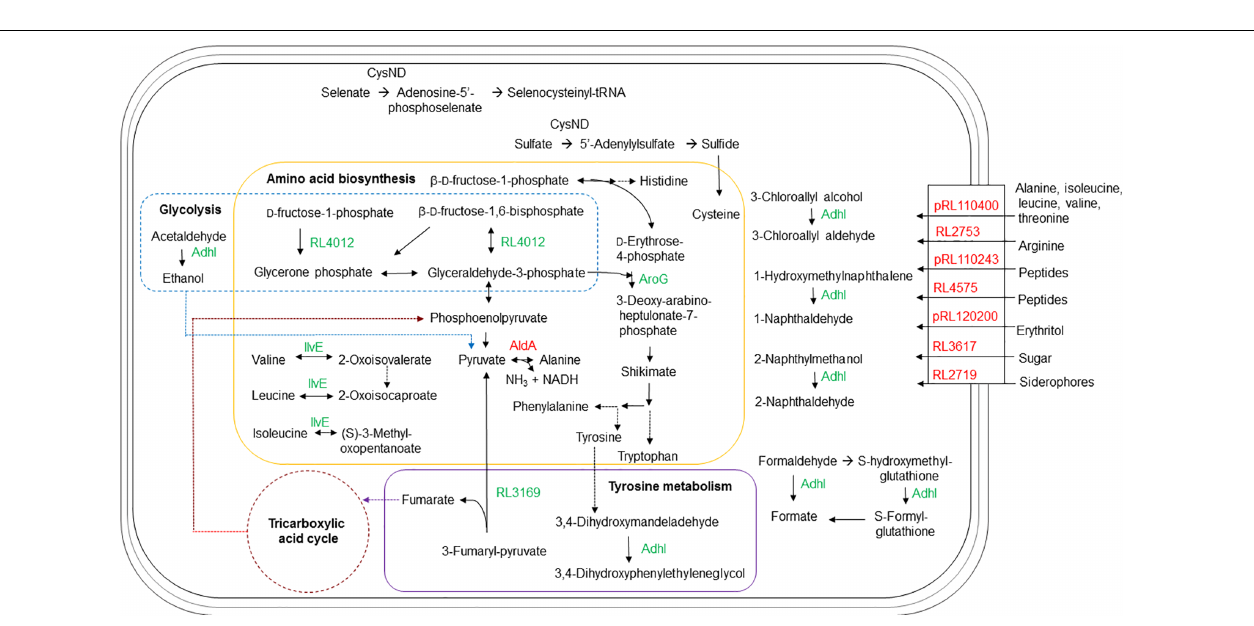
FIGURE 3 | Histograms of peak areas for 11 amino acids from culture at lag, log, early and late stationary phases for the wild type (WT) and ctpA mutant. Columns with no bars represent signal not detected. Asterisks represent statistically significant differences relative to wild-type ( p < 0.05) from a two-tailed student’s t -test.